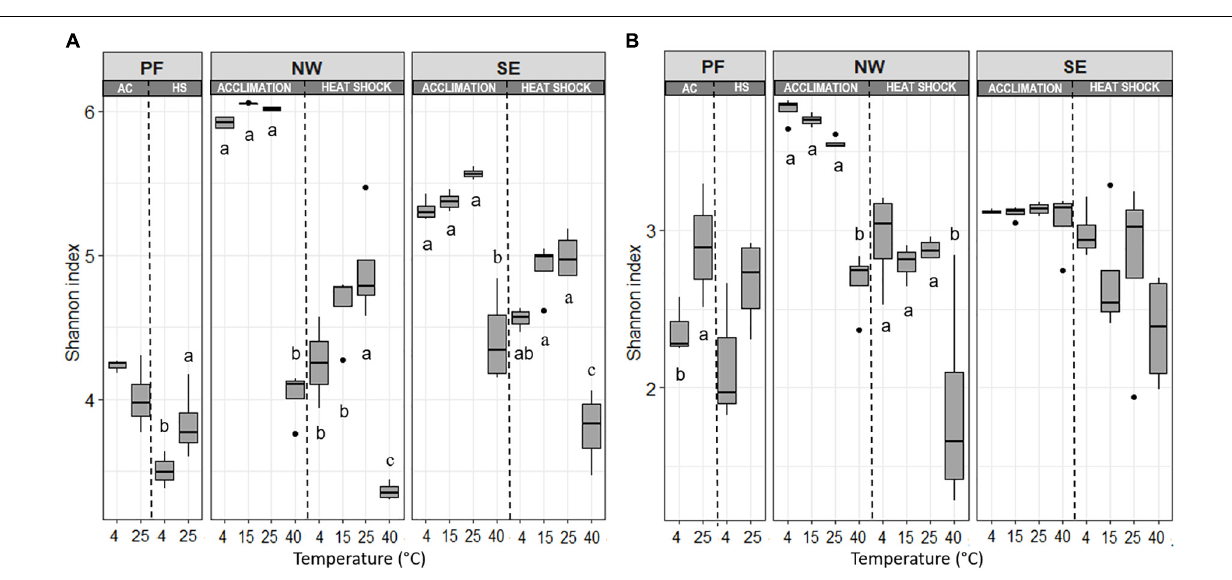
FIGURE 3 | Changes in (A) bacterial and (B) fungal Shannon index with increasing temperatures, presented separately for acclimation and for heat shock. Horizontal lines represent the median and boxes represent the range between first and third quartiles. Vertical lines represent the maximal and minimal values and points represent extremes. Different letters indicate significant differences ( p < 0.05) between temperature treatments for acclimation and heat shock assessed separately with Tukey post hoc tests. Soil origins: PF, permafrost; NW, active layer on north-western slope; SE, active layer on south-eastern slope. Temperatures: PF soils 4 and 25 ◦ C; NW and SE soils 4, 15, 25, and 40 ◦